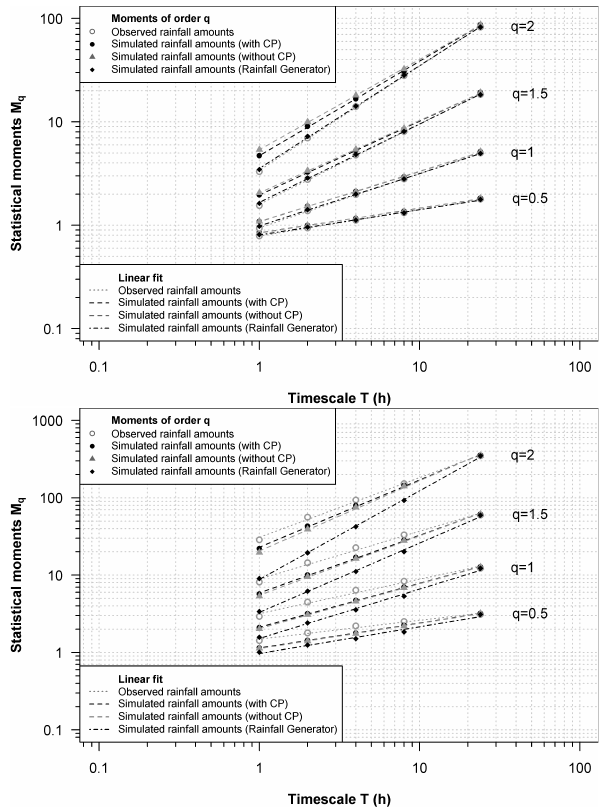
Fig. 9. Comparison of statistical moments M q of observed and syn- thetic rainfall data (averaged over 100 disaggregation runs) of the cascade models (with and without CP) and the rainfall generator as a function of timescale T between T = 1h and T = 24h for parame- terization period 1989–1999 (top) and validation period 1969–1979 (bottom) in a log-log